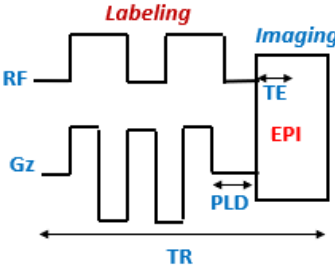
Figure 4. Schematic representation of the pCASL sequence. EPI: echo planar imaging module; TE: echo time; PLD: post-labeling delay; TR: repetition time; G z : gradient.